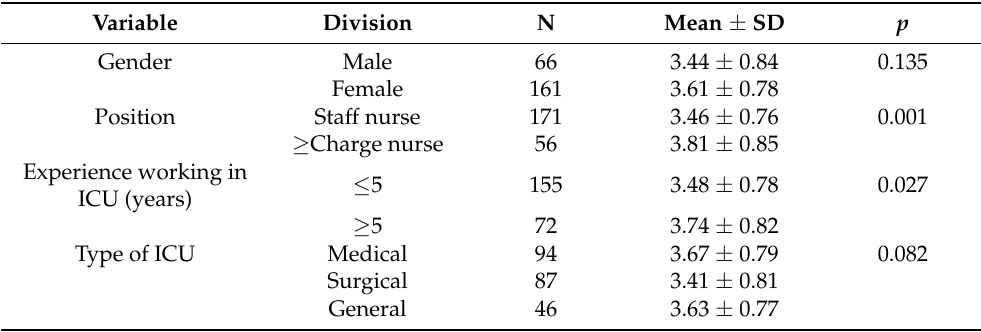
Table 4. Differences in attitudes about the importance of oral care according to the general character- istics of ICU nurses.